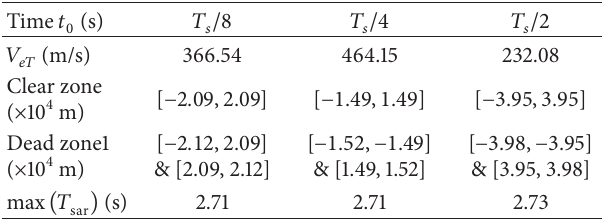
Table 3: Azimuth coverage and coherent accumulated time of GEOSAR at different time